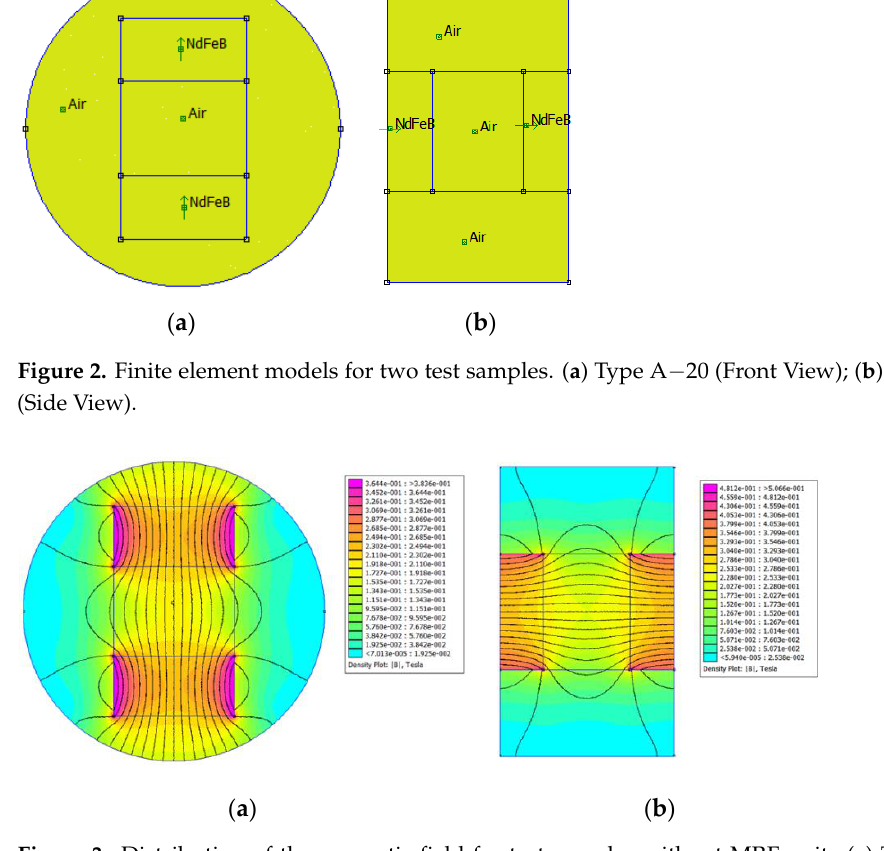
Figure 3. Distribution of the magnetic field for test samples without MRF unit. ( a ) Type A − 20; ( b ) Type B − 15.